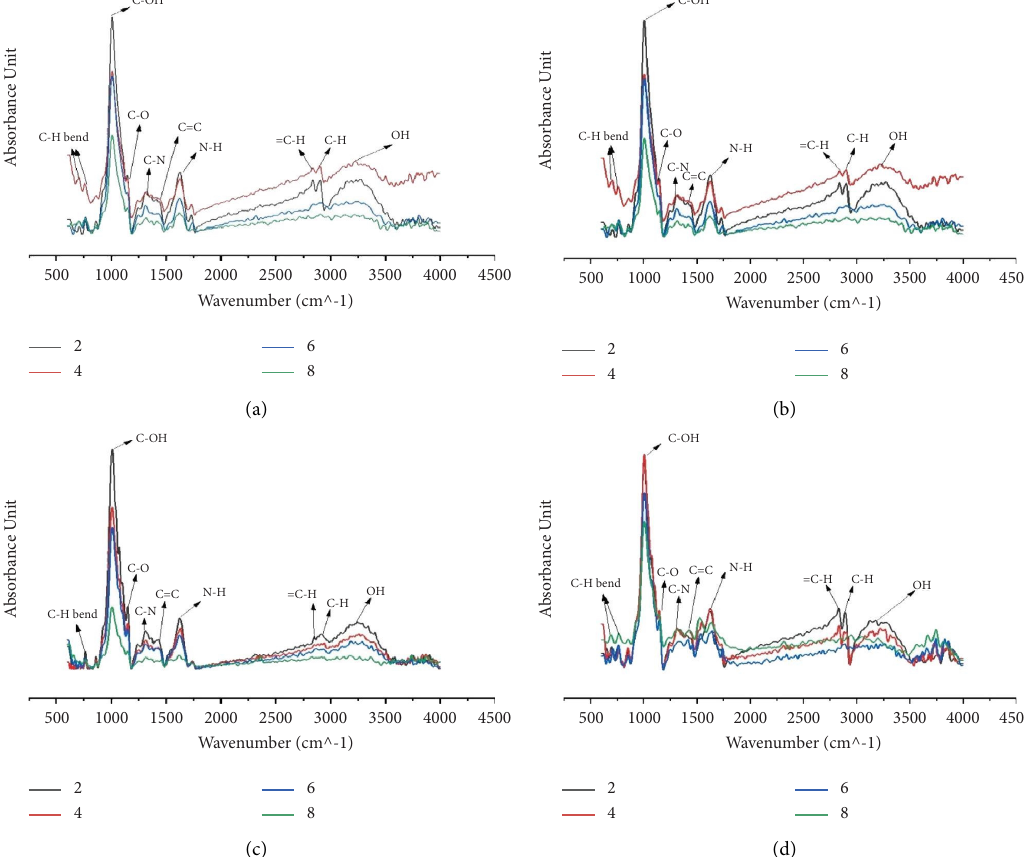
Figure 7: Fourier transform infrared spectrophotometer (FTIR) spectrum analysis of green banana four dried at 50 ° C (a), 60 ° C (b), 70 ° C (c), and 80 ° C